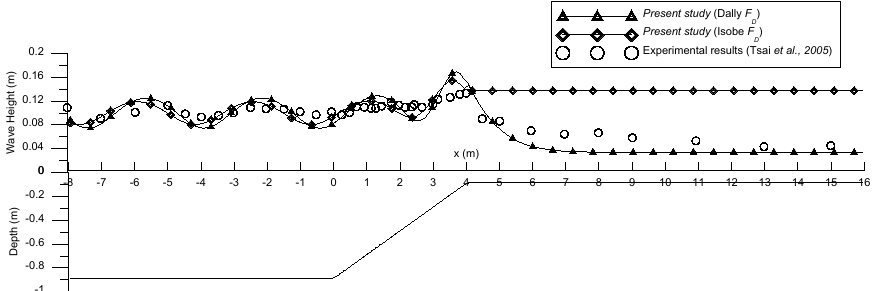
Figure 15. Wave heights for breaking and dissipation of wave by a slope of 1/5 with varying formulas of energy dissipation factors [25,27,29].